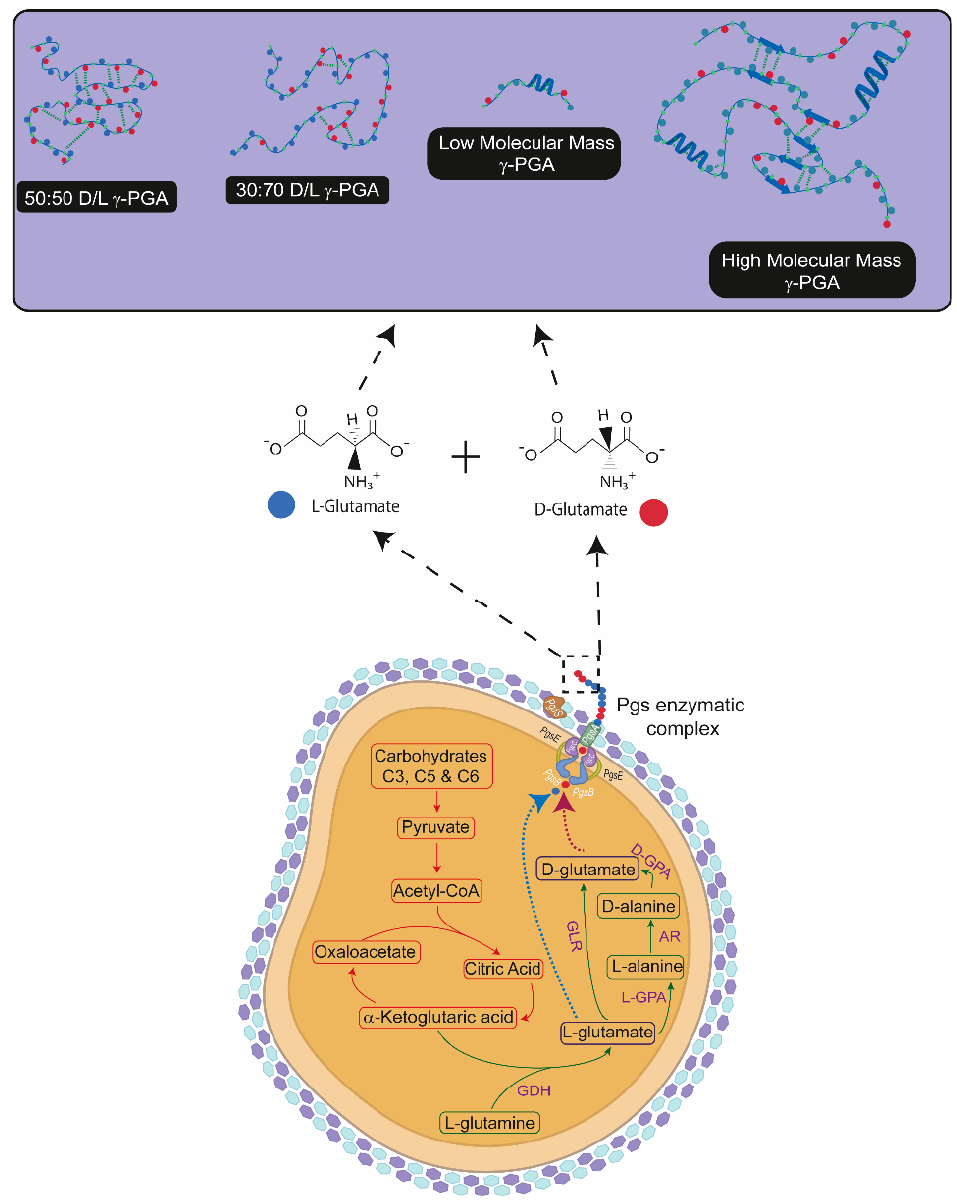
Figure 1. Factors and pathways involved in the biosynthesis of poly ( γ -glutamic acid) ( γ -PGA). Herein, the metabolic pathway (in red) of γ -PGA producers has been summarised. In red, the energy generation pathways have been shown. Similarly, γ -PGA generation intermediates/components have been presented in green. The figure also illustrates polymerisation of D - and L -glutamic acid monomers (red and blue dots respectively) into a polymeric chain by the enzymatic com- plex. The physical arrangement of the polymer, with varying D/L ratios, in solution has also been summarised. Light blue and purple hexagons represent cross-linked NAM and NAG moieties of Gram-positive peptidoglycan. GDH—Glutamate dehydrogenase; L-GPA— L -glutamic acid:pyruvate aminotransferase; AR—alanine racemase; D-GPA— D -glutamic acid:pyruvate